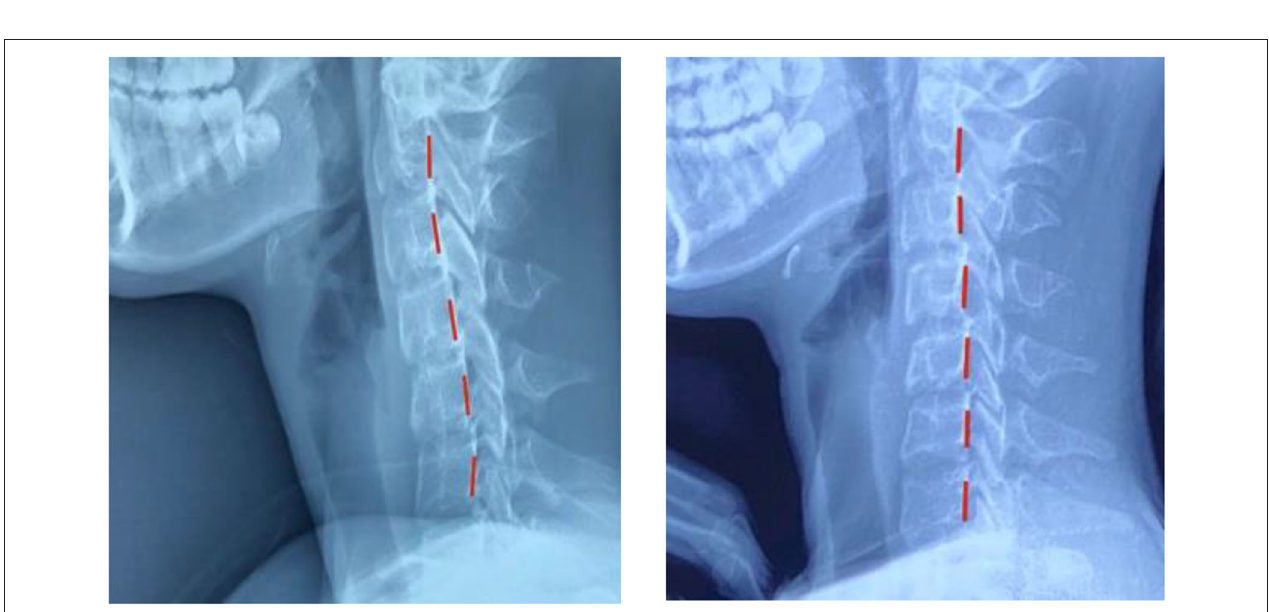
FIGURE 4 | Lateral cervical views. Left : Initial image showing prominent forward head shift. Right : Reduction of forward head shift. Red line is the patient’s position.